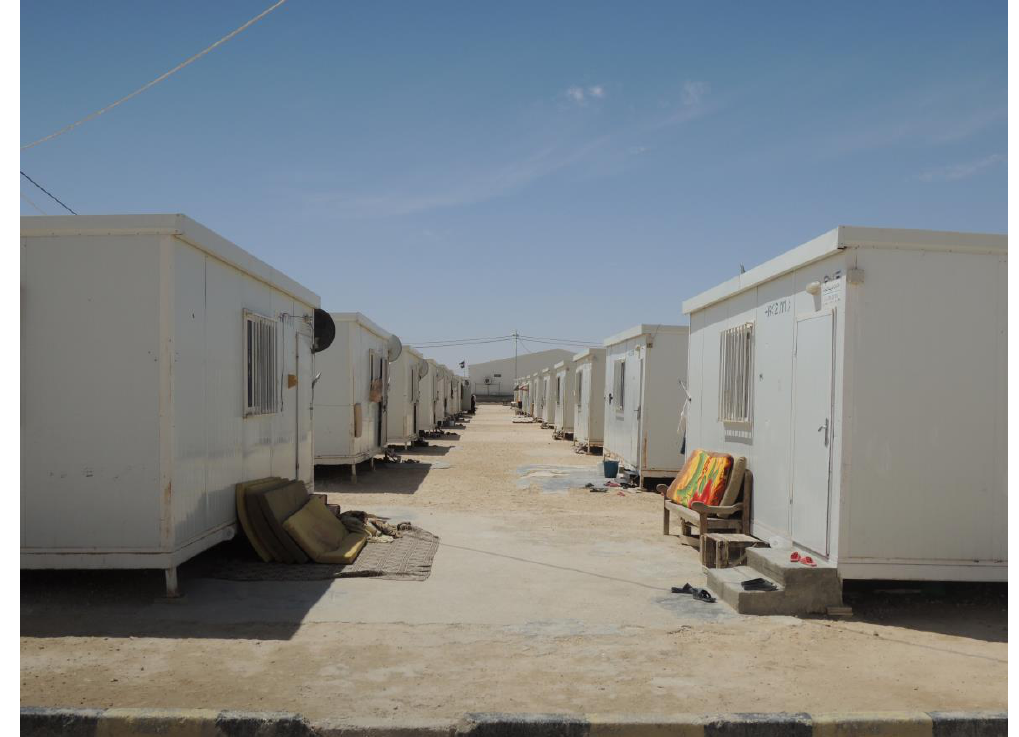
Figure 3. The Emirati-Jordanian Camp in Jordan (Source: Author, 2016)